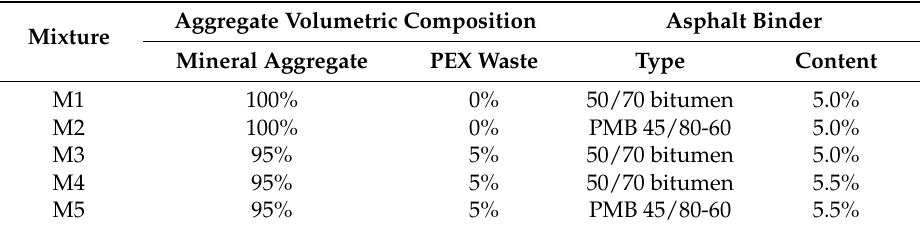
Table 3. Composition of the studied mixtures.